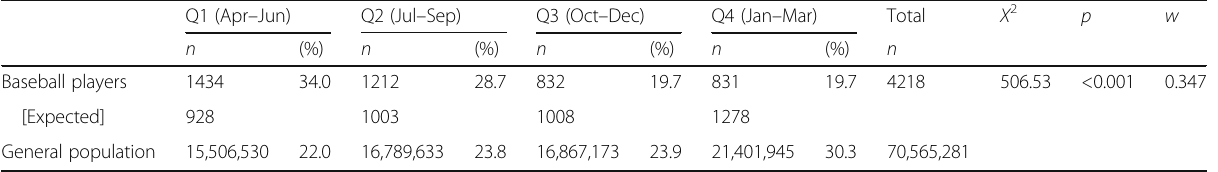
Table 2 Distribution of all players and the general population divided into quarters